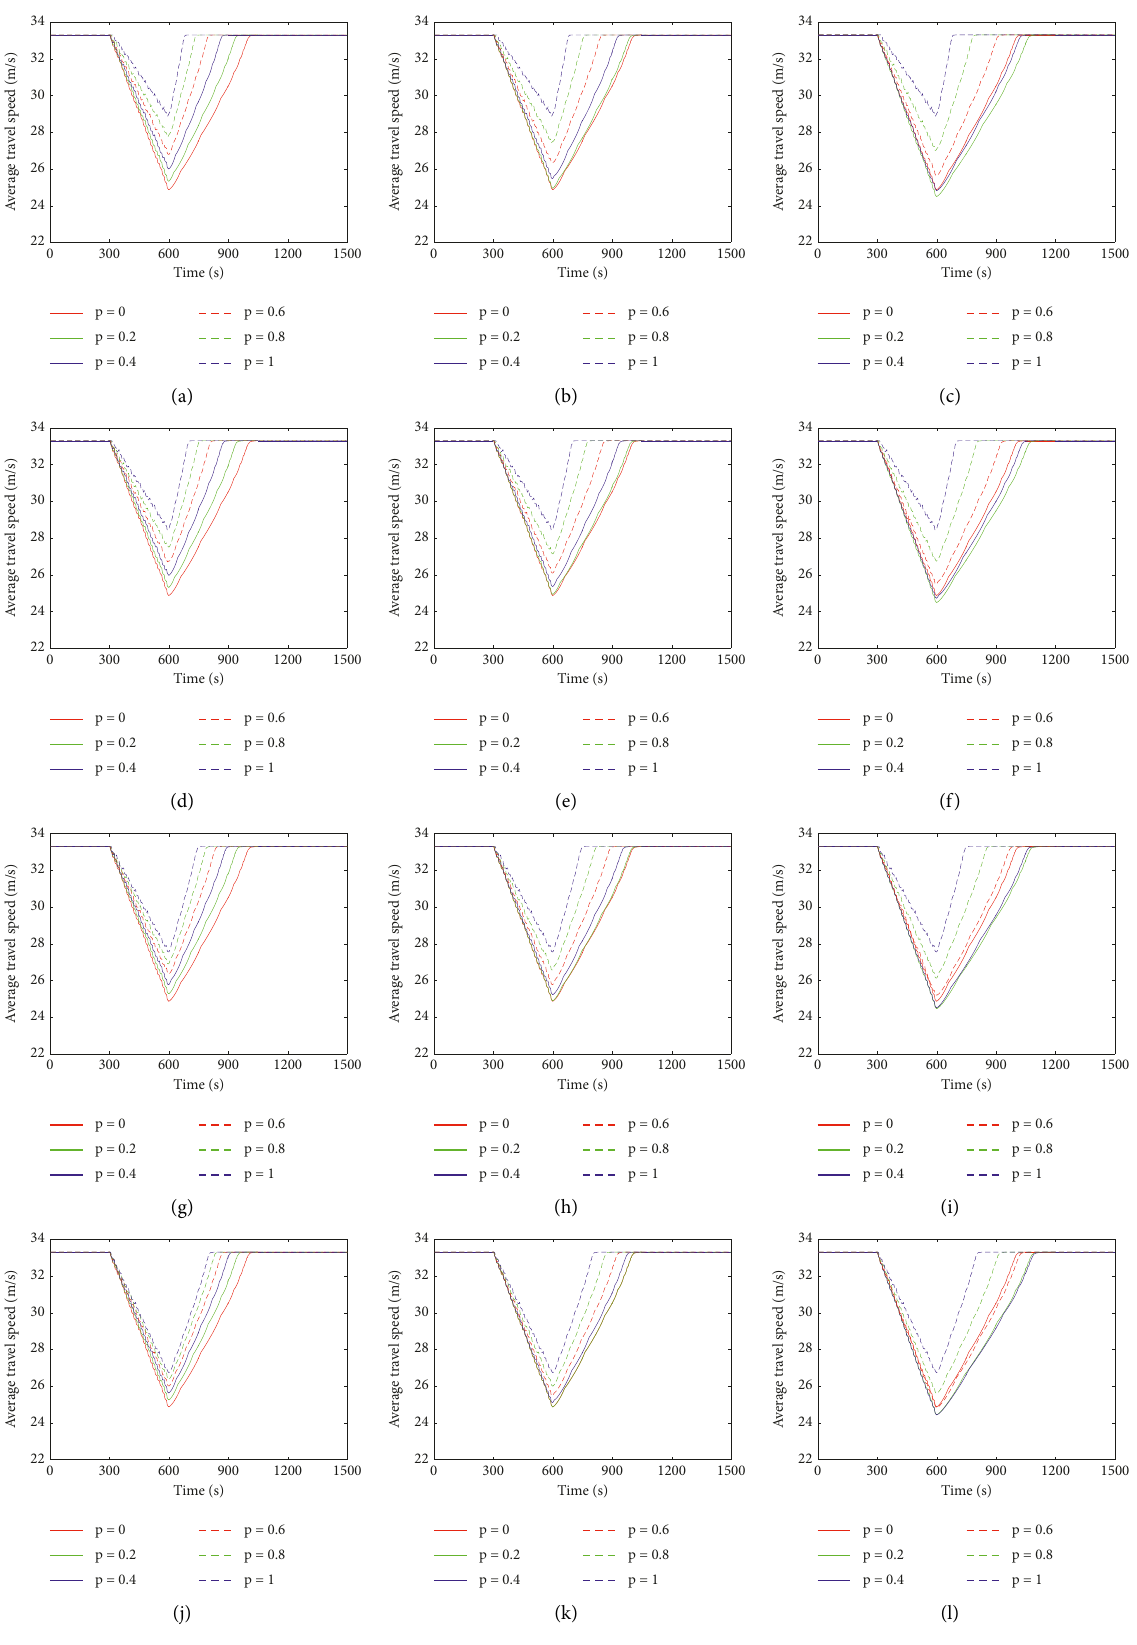
� 1 . 1 , t � 0 . 6, (b) t A C